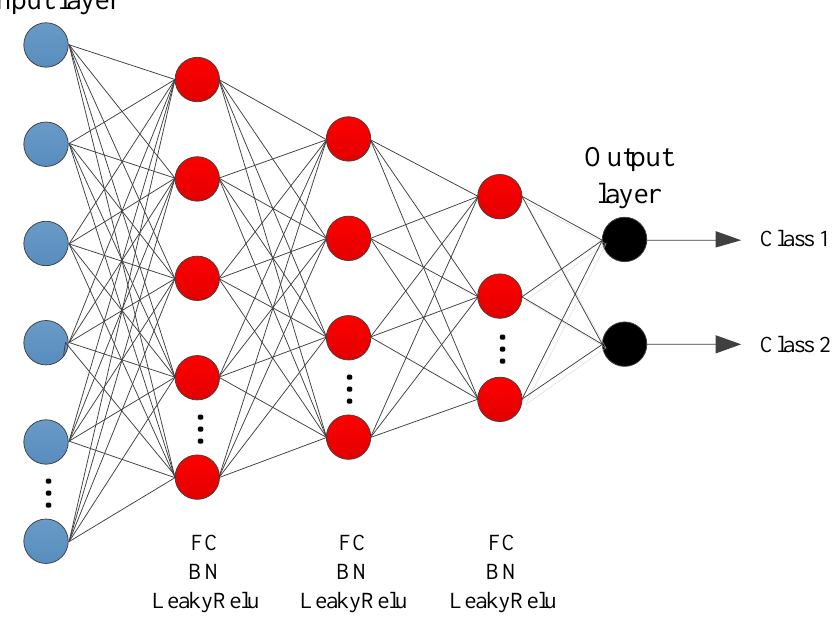
Figure 3. Fully connected neural network for